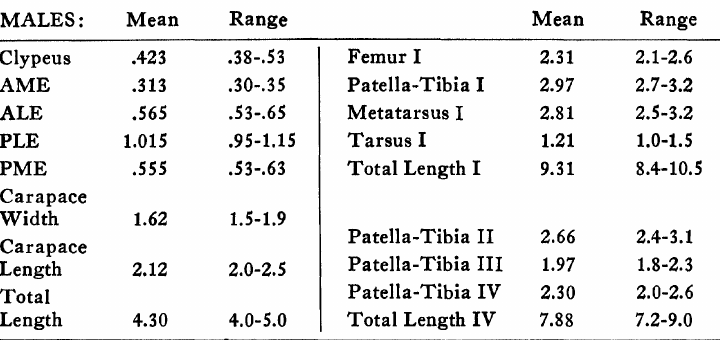
Color. Female. Face and ckelicerae cream to pale orange, lighter . along lower edge of clypeus. Darker brownish vertical stripes as in Eye region dark brown or black, overlaid with white Figure appressed